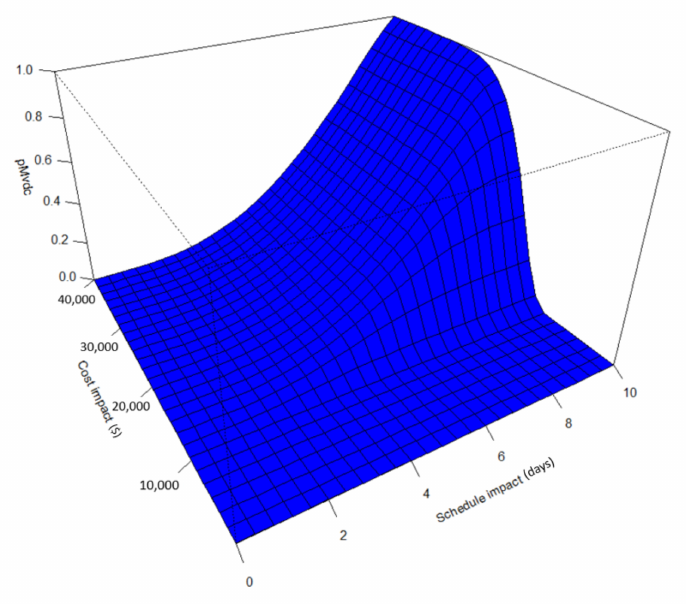
Figure 16. Cumulative density function of the joint